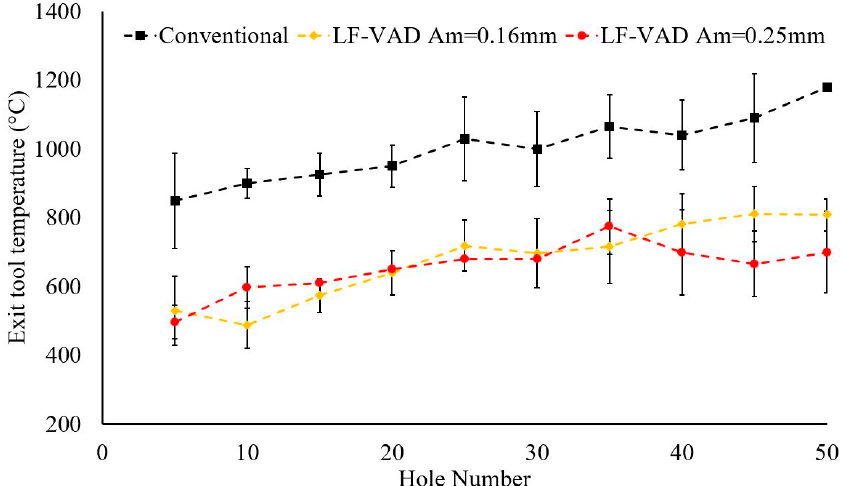
Figure 7. The effect of tool wear progress on the exit tool temperature at different vibration amplitude for N = 37.68 m/min and f = 0.075 mm/rev.